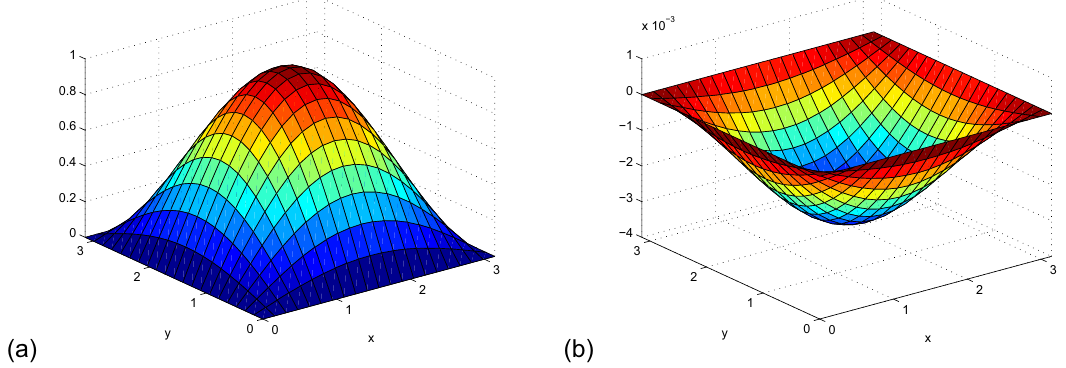
Figure 2: The plot of the numerical solution and the error between exact solution and the numerical solution computed by the proposed scheme at = T 1 with = α 1.5 , = M 20 , and = N 40 for Example 1. ( a ) Numerical solution ( b )